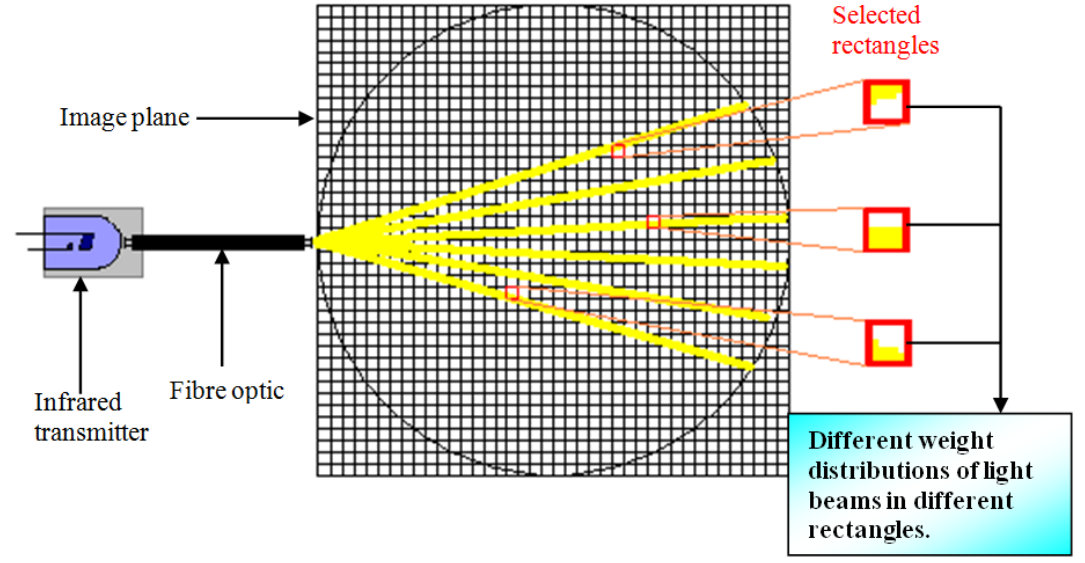
Figure 5. Fan beam projection